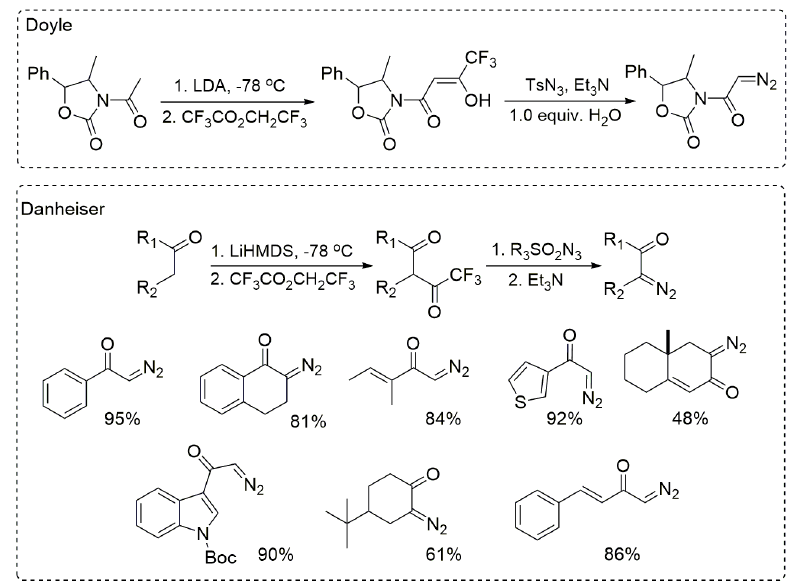
Figure 19 - Trifluoracetylation/detrifluoroacetylation diazo transfer